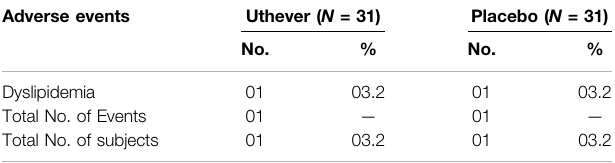
TABLE 9 | Pro fi le of adverse events. Adverse events